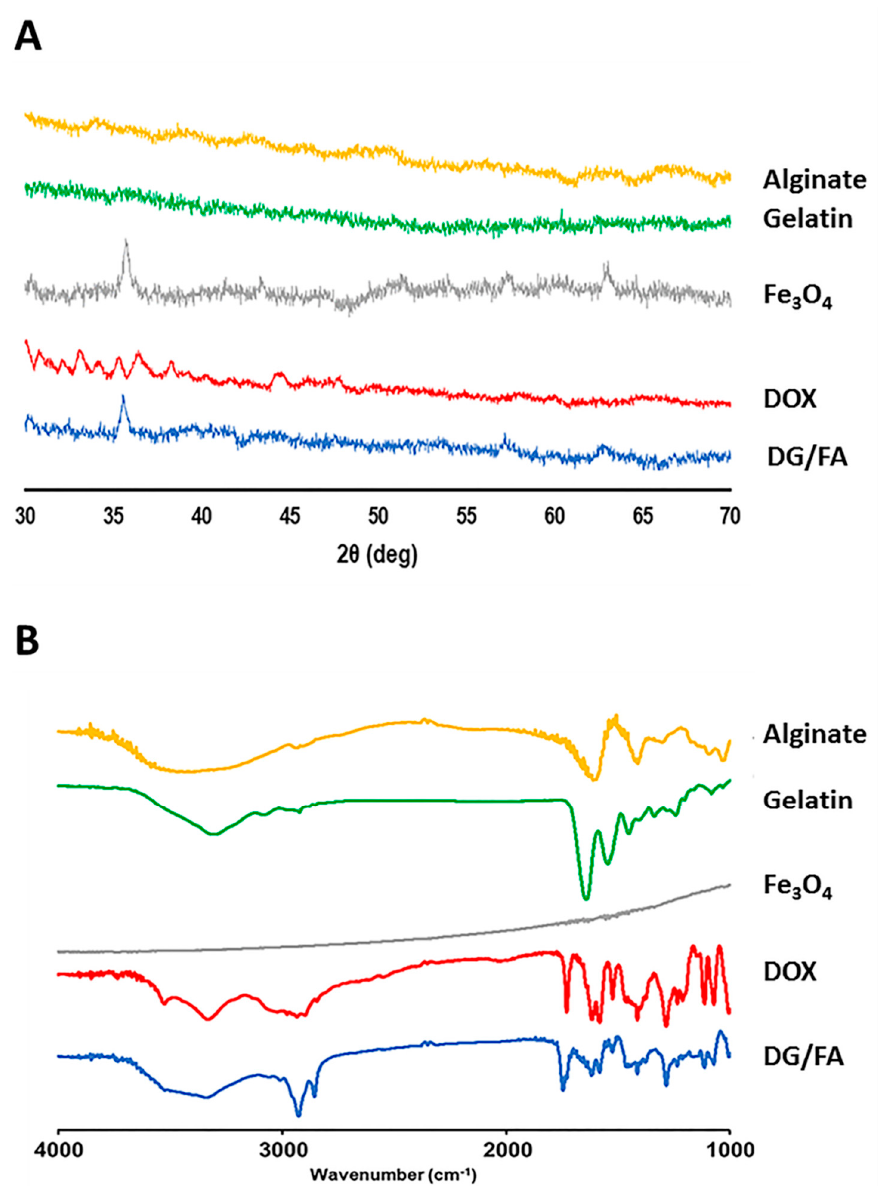
Figure 2. ( A ) XRD patterns of alginate, gelatin, Fe 3 O 4 (Fe), DOX, and DG / FA NPs. ( B ) FTIR spectra of alginate, gelatin, Fe 3 O 4 (Fe), DOX, and DG / FA